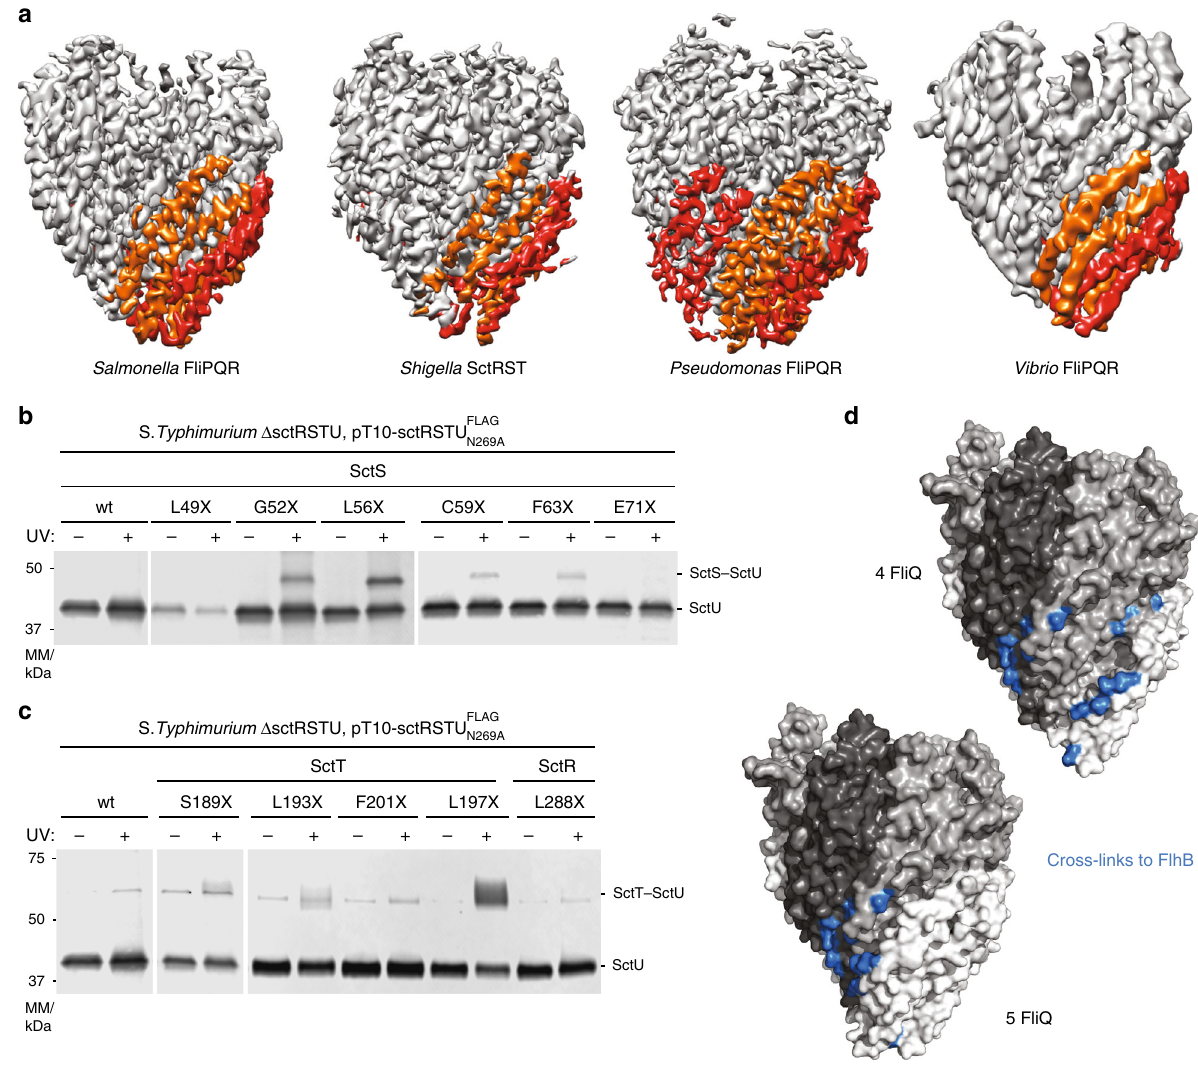
Fig. 1 Conservation of the structure of the FliPQR export gate in the closed state. a Cryo-EM volumes calculated in Relion using data from S . typhimurium FliPQR (left, EMD-4173), S. fl exneri SctRST (centre left, SctR 5 S 4 T 1 class 10 (EMD-4734)), P. savastanoi FliPQR (centre right) and V. mimicus FliPQR (right). FliQ 2 and FliQ 4 are coloured orange and FliQ 1 , FliQ 3 and FliQ 5 are coloured red. b Immunodetection of SctU FLAG on western blottings of SDS-PAGE- separated crude membrane samples of the indicated S . typhimurium SctS p Bpa mutants (denoted with X). Each sample is shown with and without UV- irradiation to induce photocrosslinking of p Bpa to neighbouring interaction partners. c As in b , but testing interactions to SctU with p Bpa in SctTand SctR. d Mapping of the con fi rmed contact points between FliPQR/SctRST and FlhB/SctU, including those previously identi fi ed 19 on the structure of FliPQR ( S . typhimurium ) and a model with a fi fth FliQ subunit, which is based on the structure of P. savastanoi